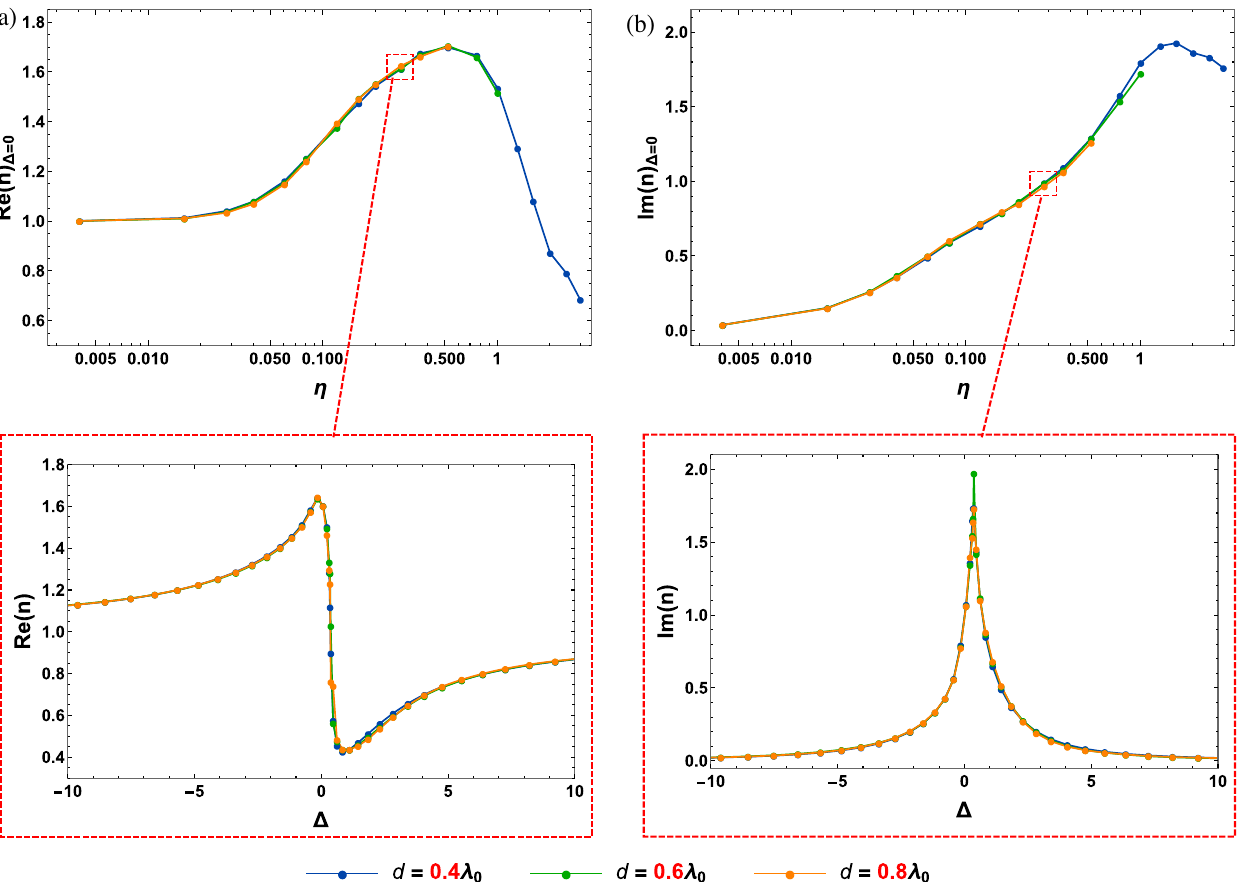
FIG. 7. Independence of the refractive index from the thickness of the ensemble. Given the physical system of Fig. 2(a) of the main 5 λ Δ ¼ 0 ) refractive index as a function of the density for various ensemble text (with w 0 ¼ 2 . 5 λ 0 , l 0 ), we compare the resonant ( cyl ¼ thicknesses: d ¼ 0 . 4 λ 0 (as in the main text, shown here in blue), d ¼ 0 . 6 λ 0 (in green), and d ¼ 0 . 8 λ 0 (in orange). Panels (a) and (b) illustrate the real and imaginary parts of the index, respectively. The insets show the full spectra n ð Δ Þ at a fixed density η ≃ 0 . 28 . All data are obtained by averaging h t ð Δ Þi over more than 1000